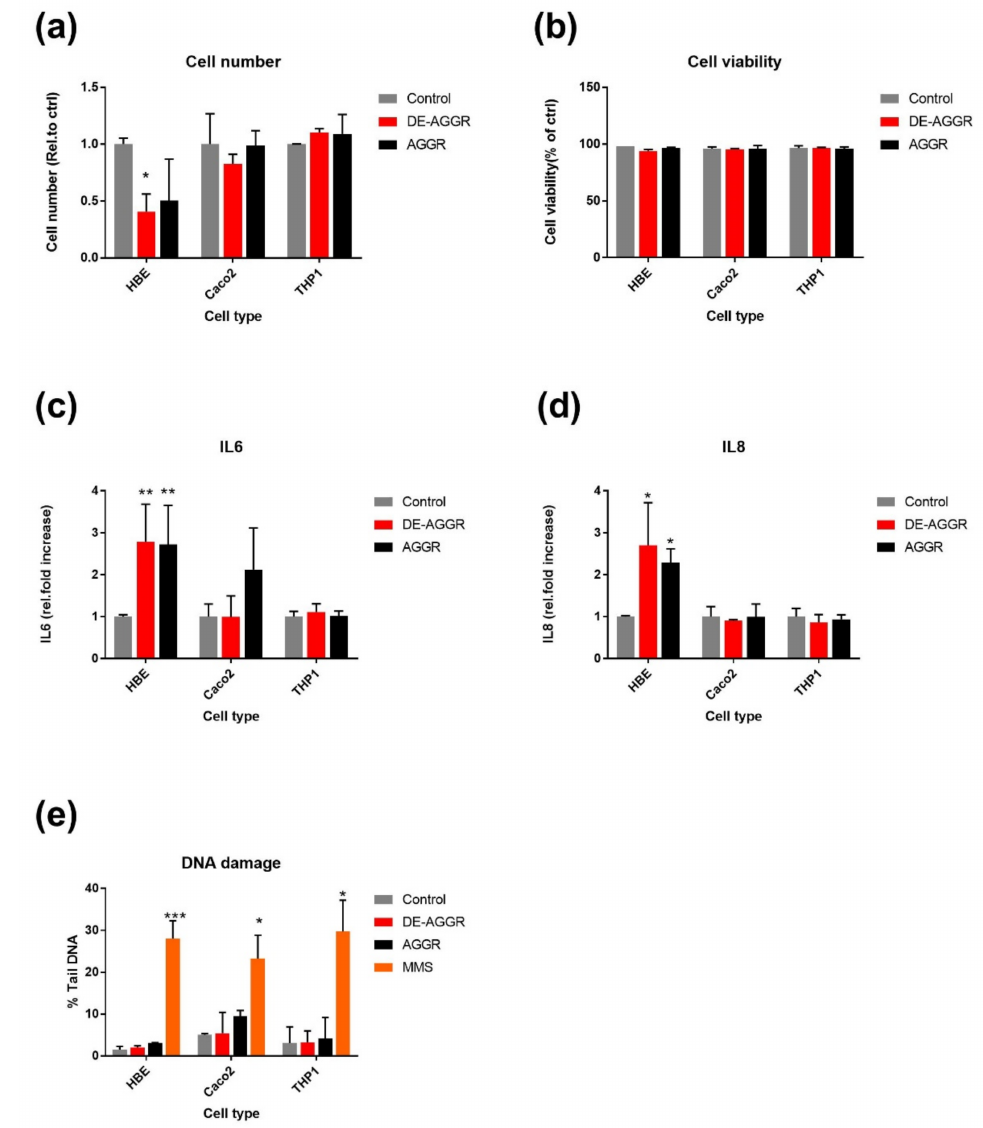
Figure 3. Effect of repeated exposure to SAS suspensions (0.76 µ /cm 2 ) on biological responses. Cell proliferation ( a ), viability ( b ), IL-6 ( c ), IL-8 ( d ), and DNA damage ( e ) was measured in different cell cultures after third exposure cycle. Data are expressed as means ± SD from two independent experiments performed in duplicate. p < 0.05 (*), p < 0.01 (**) and p < 0.001 (***) represent significant differences compared to control (One-way ANOVA followed by Dunnett’s multiple comparison